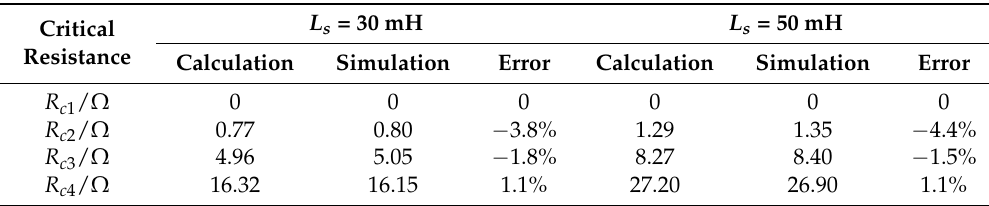
Table 1. Comparison between calculation results and simulation results of critical